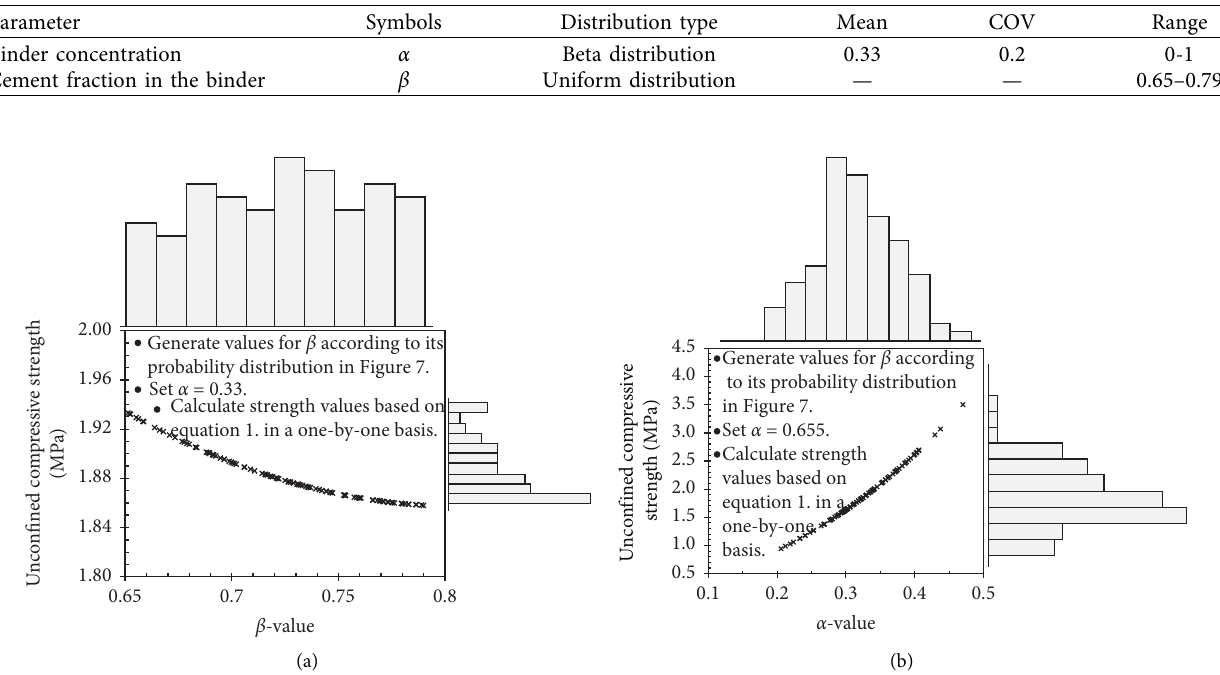
Figure 8: Illustrations of the Monte Carlo simulation method to examine the effect of variation in (a) β and (b) α on unconfined compressive strength ( α, binder concentration; β, cement fraction in the